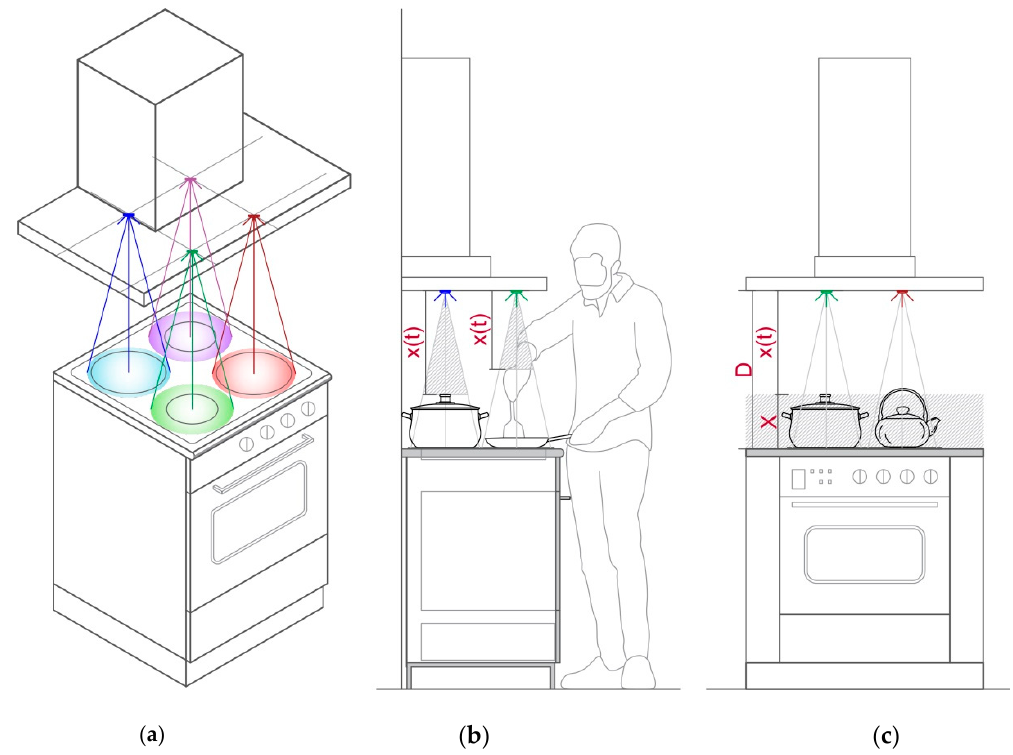
Figure 2. Illustration of the sensing system and corresponding distance measurement parameters; ( a ) axonometric view with the position of sensors, as well as relation between cooking area and hood; ( b ) side view; ( c ) front view.